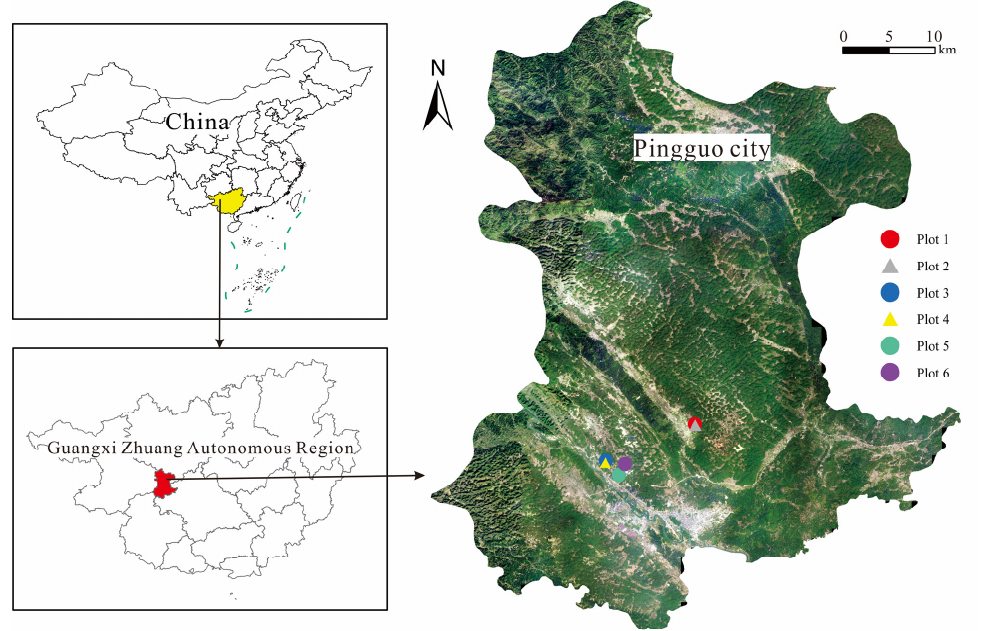
Figure 1. Location of the study area.